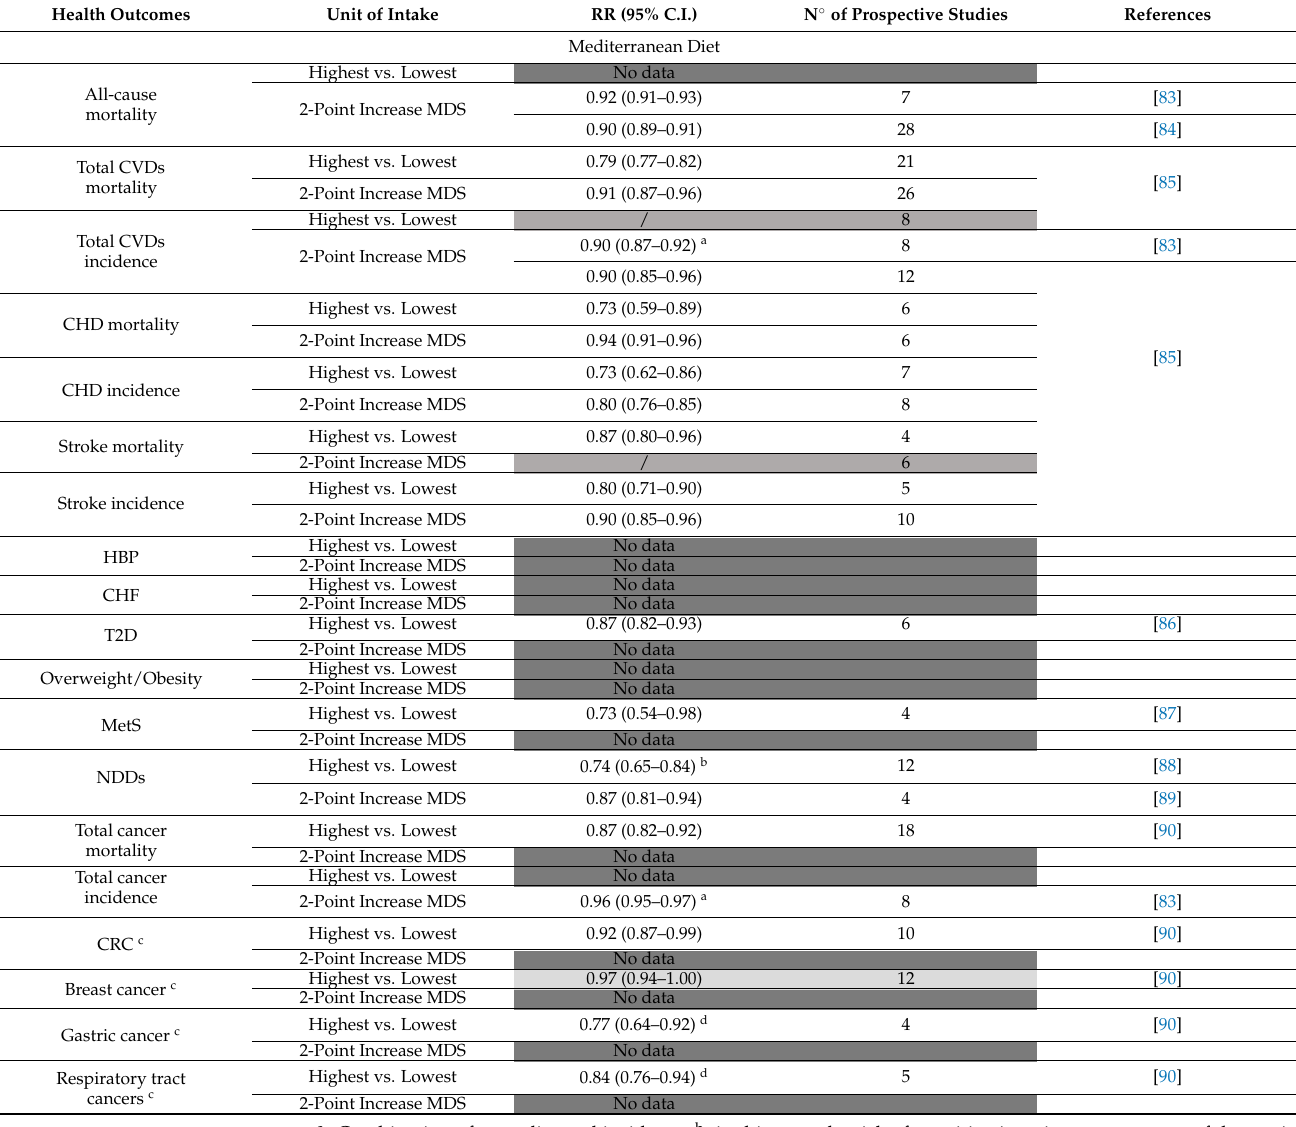
Table 2. The most relevant health benefits from good adherence to the Mediterranean diet found in some of the main prospective studies of the last decade. Data inserted refer to a fixed-effects